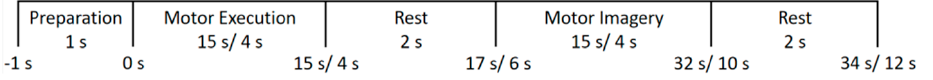
Figure 2. Timing paradigm of one trial: the duration of motor execution can be 15 s (tapping each finger for 3 s) or 4 s (other tasks); the endpoint of motor imagery depends on the participant’s self-regarded “completion”. The overall time course is estimated and denoted at the bottom. It can vary between subjects and tasks.